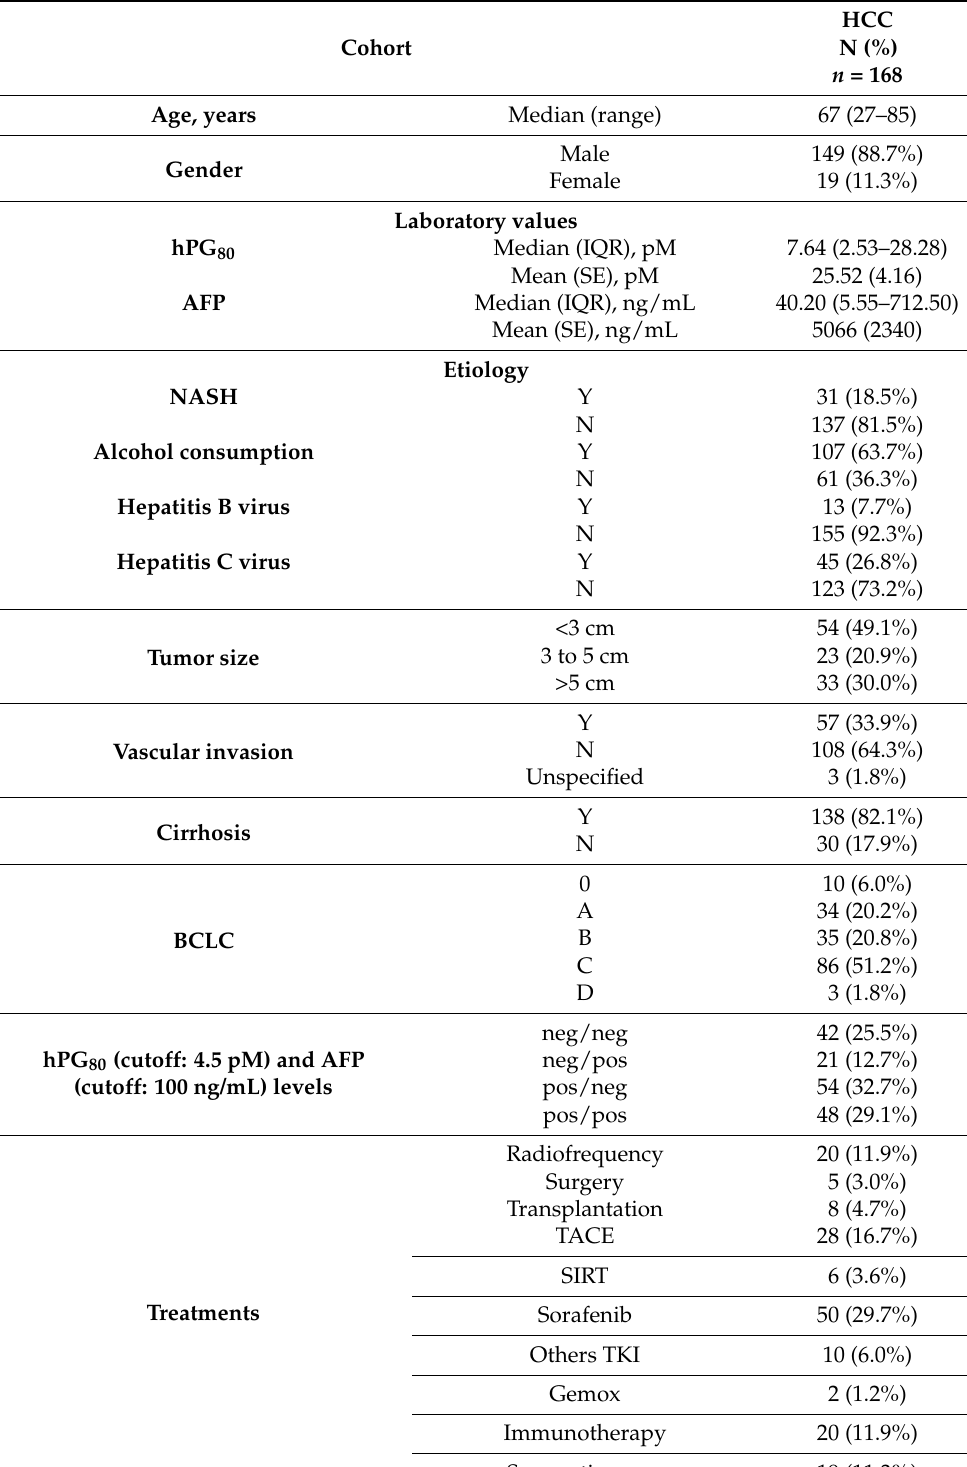
Table 1. Clinical and pathological characteristics for HCC patients and control